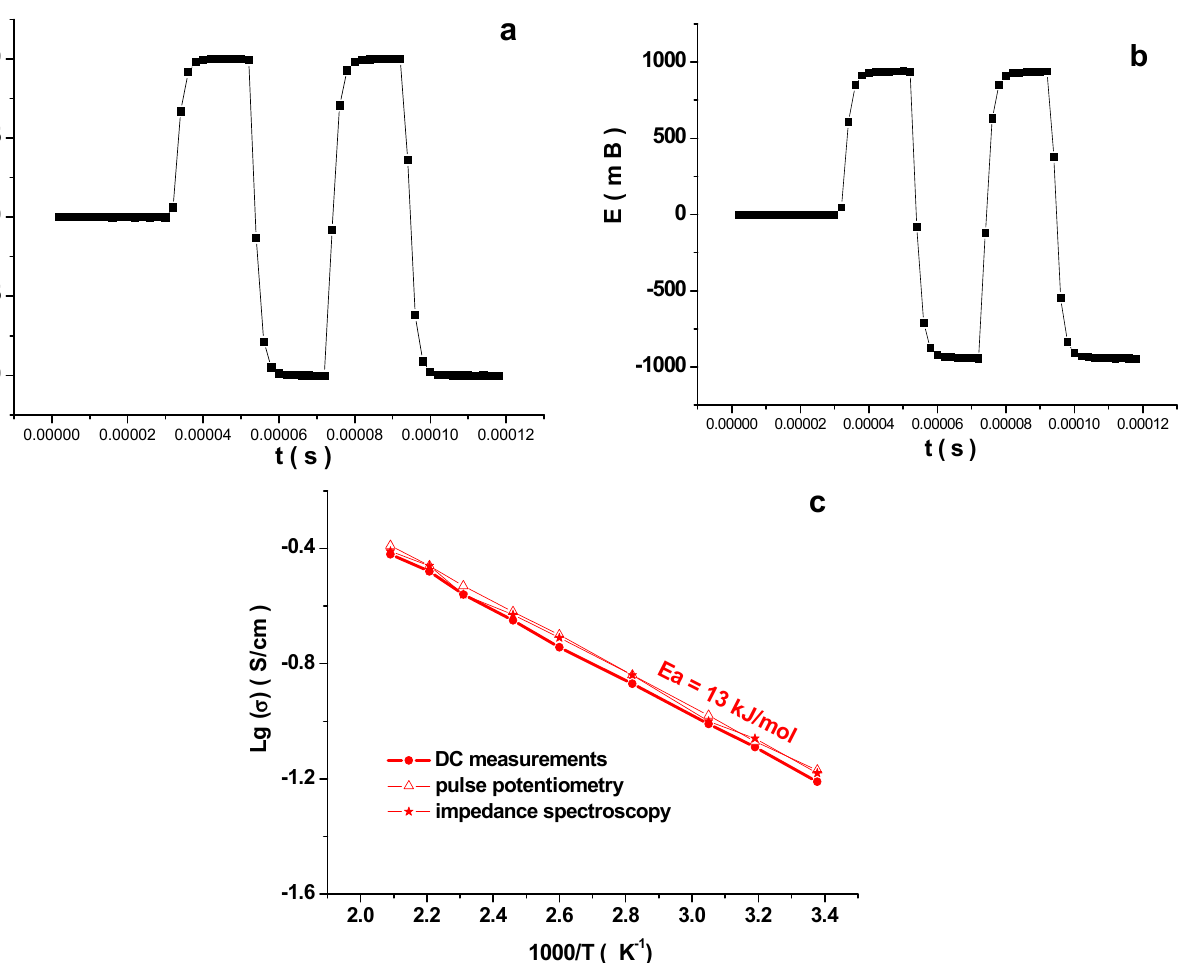
Figure 6. Results of measuring the resistance of the Ga-Ag|NaV 3 O 8 | Ga-Ag cell by pulsepotentiometry. ( a ) Current pulse, ( b ) voltage response; t = 25 °C. ( c ) Temperature dependences of conductivity for NaV 3 O 8 obtained by solid-state synthesis.